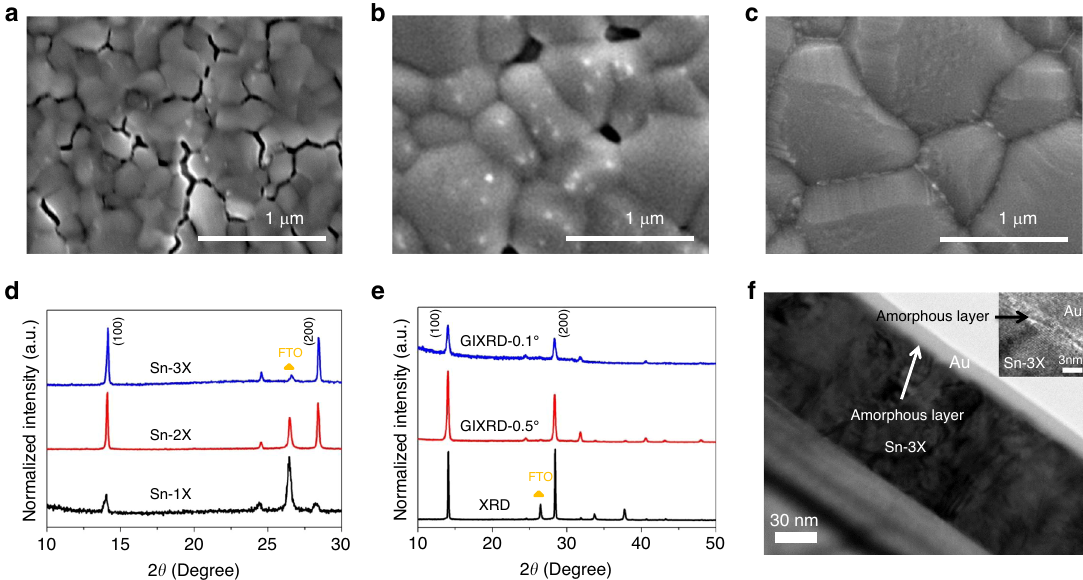
Fig. 1 Crystallization of tin perovskite fi lms. a SEM images of Sn-1X, b Sn-2X, and c Sn-3X. d The XRD patterns of the corresponding three samples. e The XRD and GIXRD patterns of Sn-3X; the incident angles of GIXRD are 0.5° and 0.1°, respectively. f TEM and HRTEM (inset) images of Sn-3X fi lm sample fabricated by focused ion beam Fig. 10a – c (top)), which further con fi rmed that it is not simply a